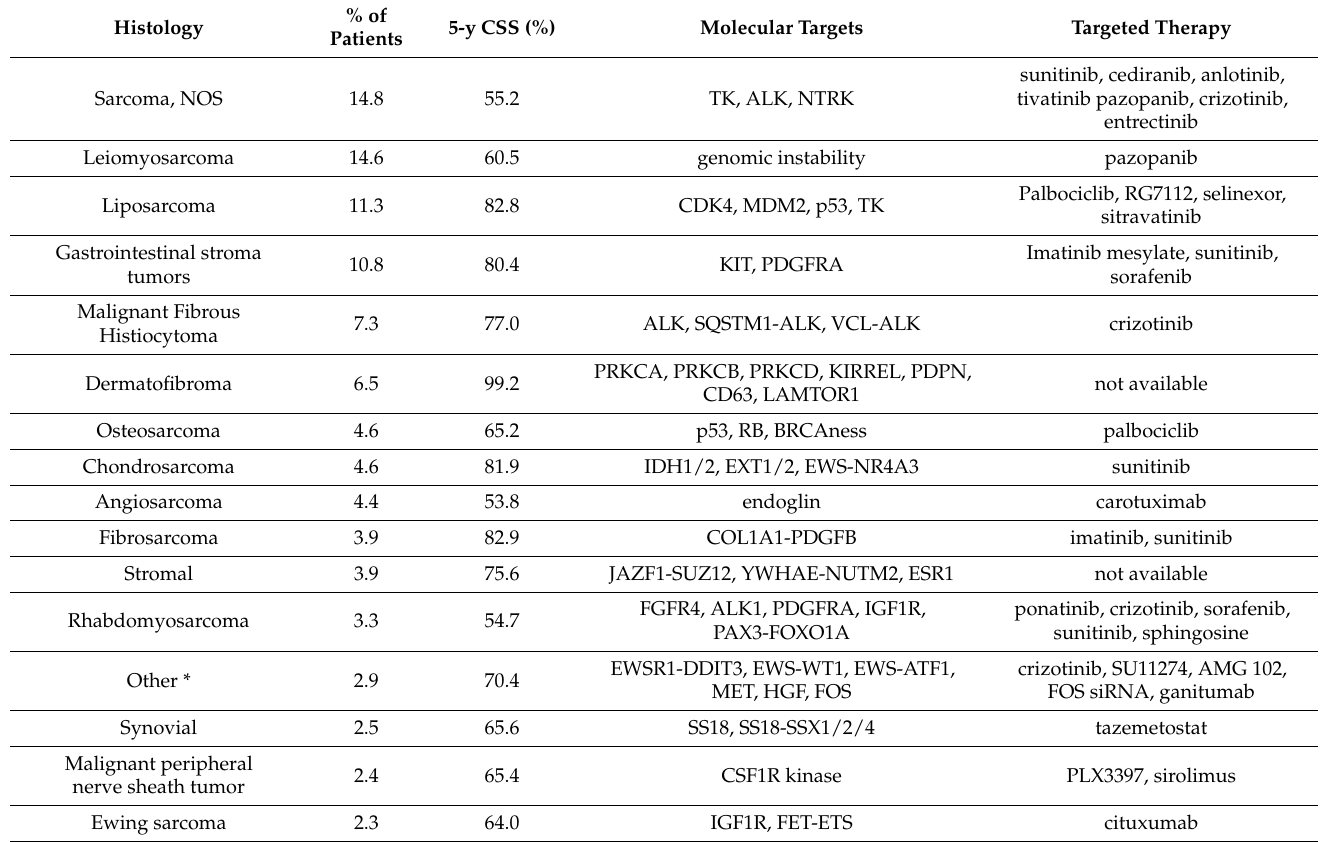
Table 1. Selected clinical and molecular characteristics of sarcomas with potential targeted therapies